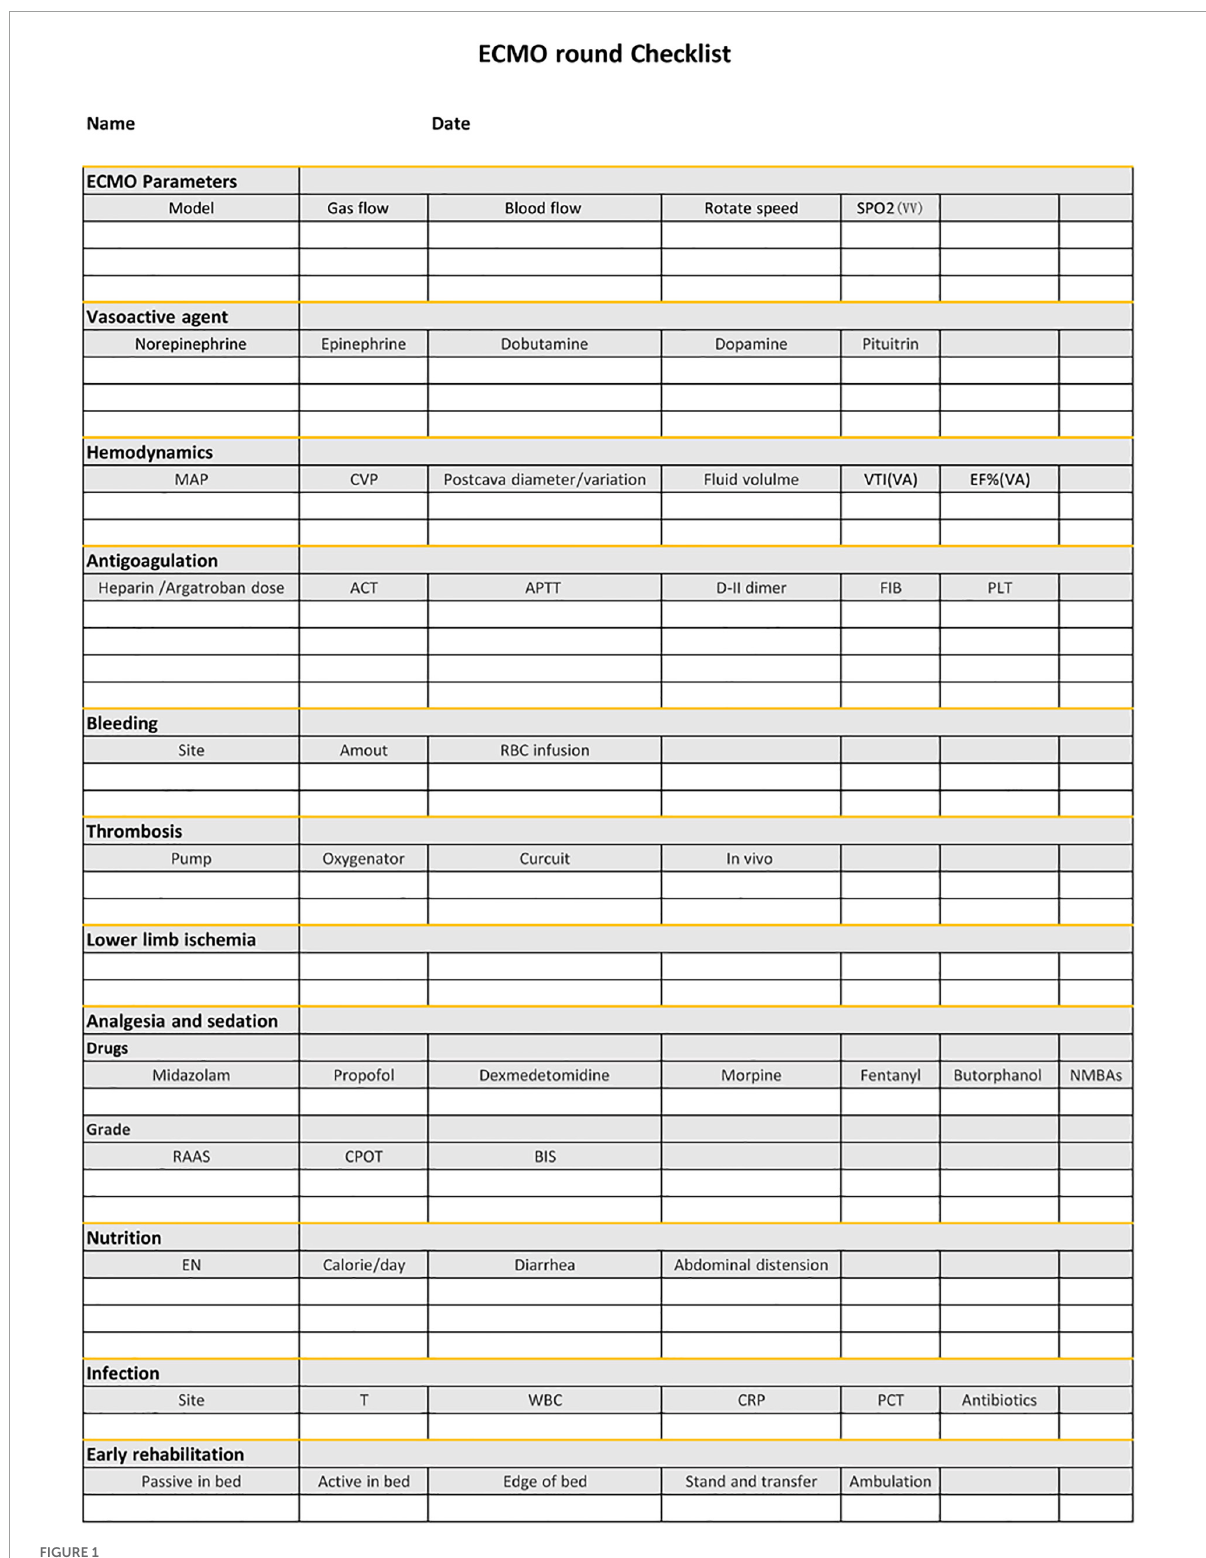
FIGURE1 The checklist during the ward round following the intervention bundle. ECMO, extracorporeal membrane oxygenation; MAP, mean arterial pressure; CVP, central venous pressure; VTI, velocity time integral; EF%, ejection fraction; ACT, activated clotting time; APTT, activated partial thromboplastin time; FIB, fibrinogen; EN, enteral nutrition; T, temperature; WBC, white blood cells; CRP, C-reactive protein; PCT,